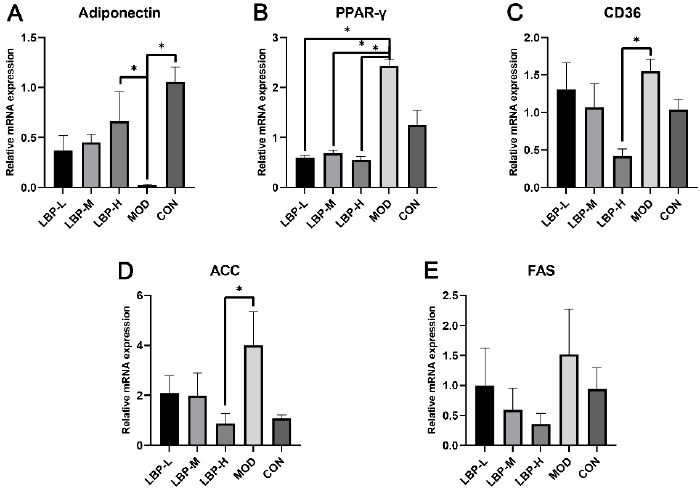
Figure 3. Effects of LBP feeding on gene expression (( A ) adiponectin; ( B ) PPAR- γ ; ( C ) CD36; ( D ) ACC; ( E ) FAS) of lipid-related metabolism in high-fat diet induced obese mice. LBP, Lycium barbarum polysaccharide; PPAR- γ , peroxisome proliferator-activated receptor γ ; CD36, Cluster of Differentiation 36; ACC, acetyl-coA carboxylase; FAS, fatty acid synthase. *, p < 0.05, compared with the model group (MOD). Sample size for each group = 8.